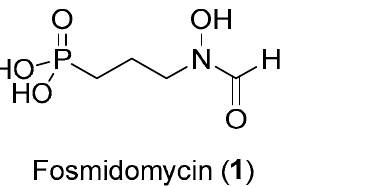
Figure 1. Structural formula of the natural product fosmidomycin ( 1 ) and its acetyl analog FR900098 ( 2 ).